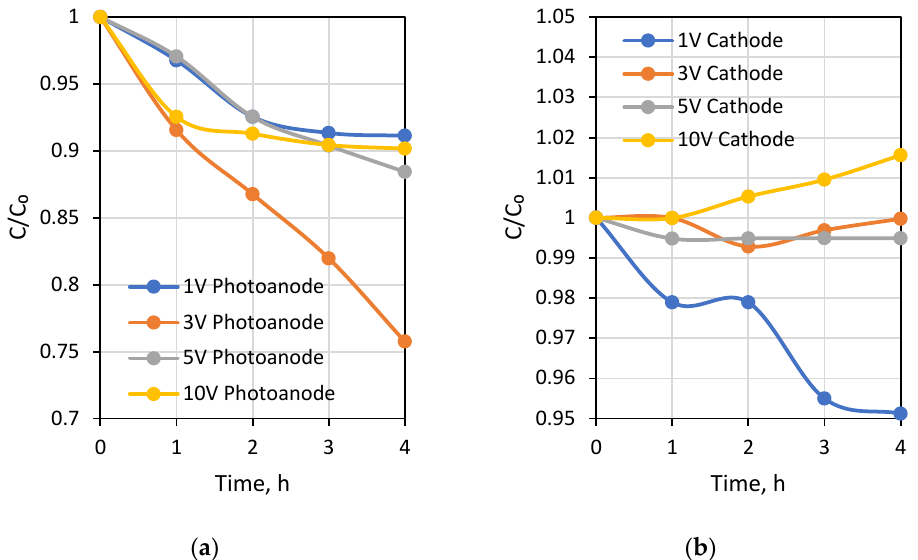
Figure 5. Change of Na + concentration with time in ( a ) photoanode, ( b ) cathode chambers at various applied voltages.